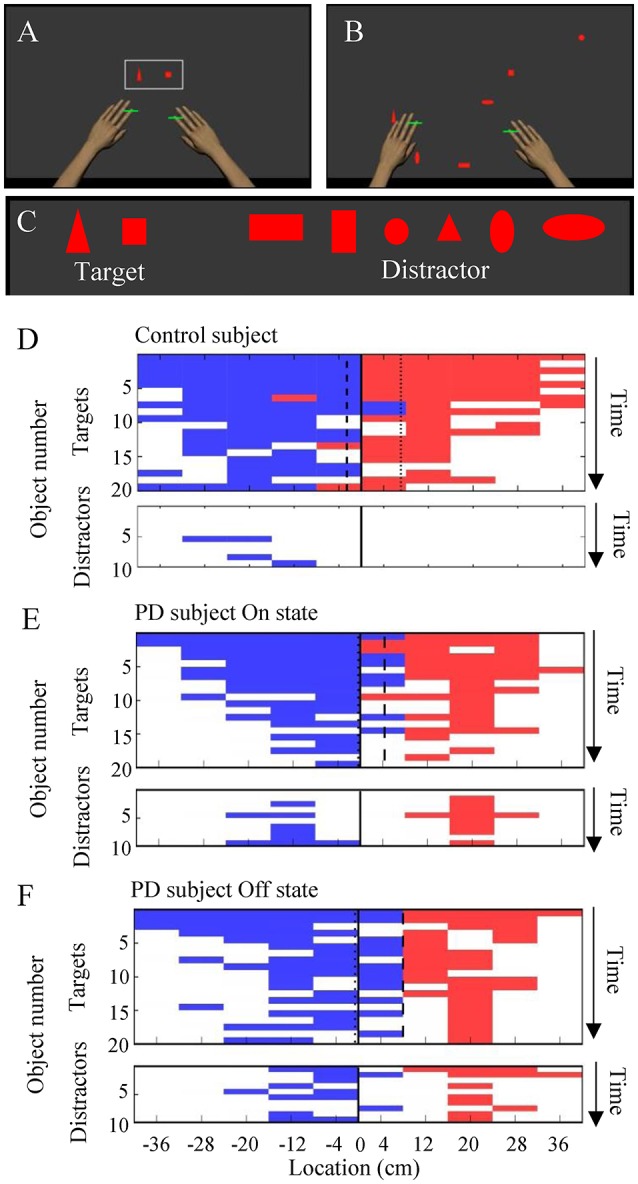
The object hit and avoid task and the results from exemplar subjects. (A–C) Virtual reality set-up. Two green cursors indicate the position of the middle fingers, which moved contingently with hand movement. The shapes of hit targets were displayed at the beginning of the task (A). Targets and distractors fell down from the top of the screen (B). Objects included two target shapes and six distractor shapes (C). (D–F) Task performance results from exemplar subjects (D, control; E, PD in On state; F, PD in Off state; E,F are from the same subjects). The objects hit by the left and right hands are plotted in blue and red, respectively, at specific time (vertical axis) and at the specific spatial bin (horizontal axis). The target and distractor objects are plotted in the upper and lower panels, respectively. White areas indicate objects that were not hit.